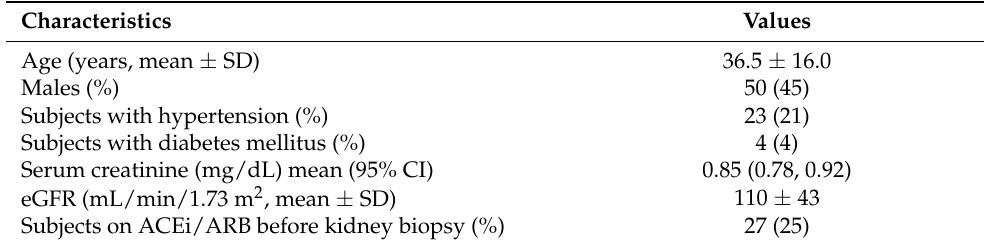
Table 1. Clinical characteristics of 110 patients with IgAVN.